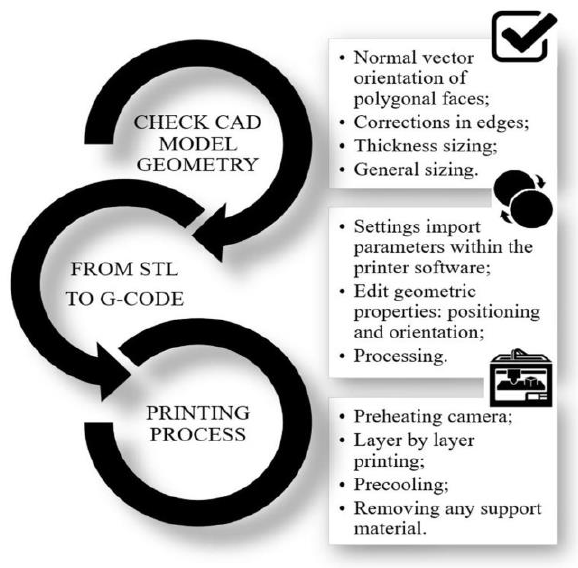
Figure 8: From check model to printing process.